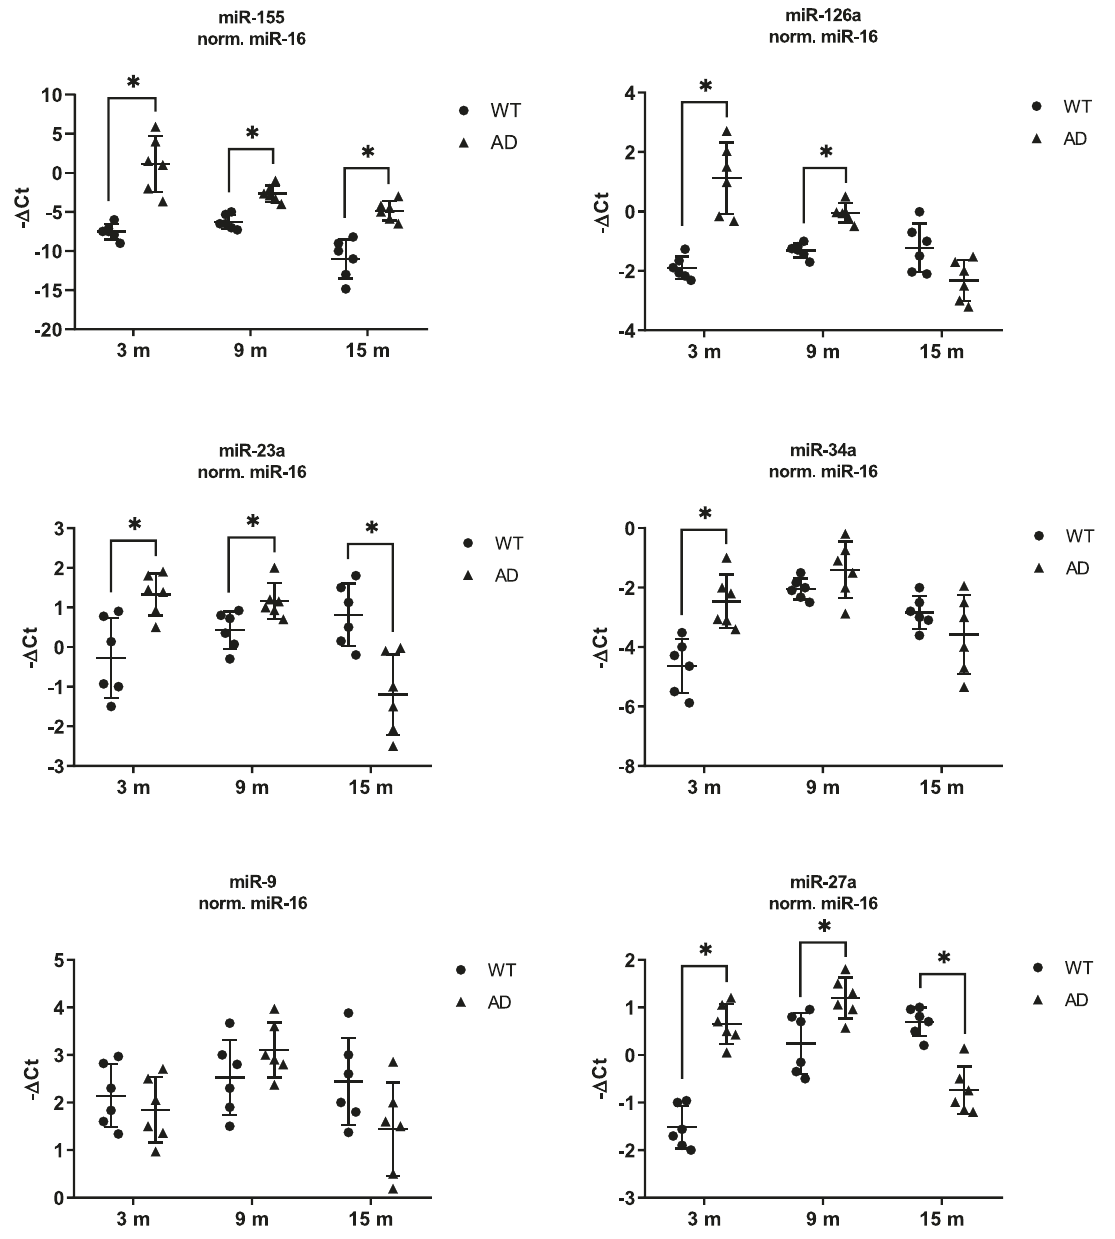
Fig. 1 Differential expression analysis of miRNAs in the retina of 3xTg-AD mice. RT-qPCR was performed to determine the expression of miR-155, miR-126a, miR-23a, miR-34a, miR-9, miR-27a in the retinas from 3xTg-AD mice at three different (3-, 9-, and 15-month-old) age periods. Data are expressed as mean ± standard deviation. One-way ANOVA and Tukey ’ s multiple comparisons test were used to determine statistical signi fi cance. * p < 0.05 vs . WT age-matched mice. N = 6 animals; 6 independent retinal samples, 2 pooled retinas per sample in each